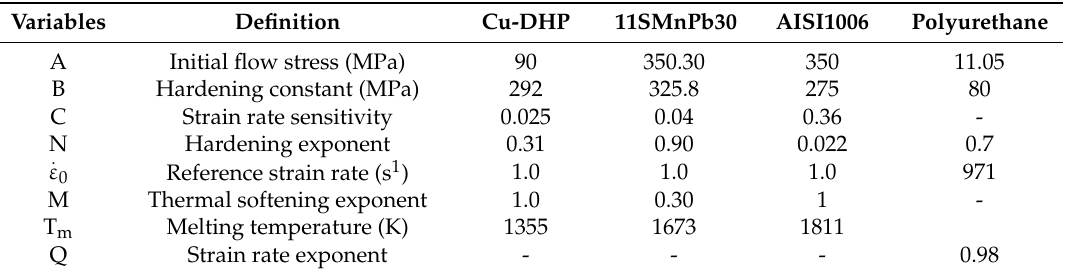
Table A2. Material constants for di ff erent materials in Equations (A1) and (A2).